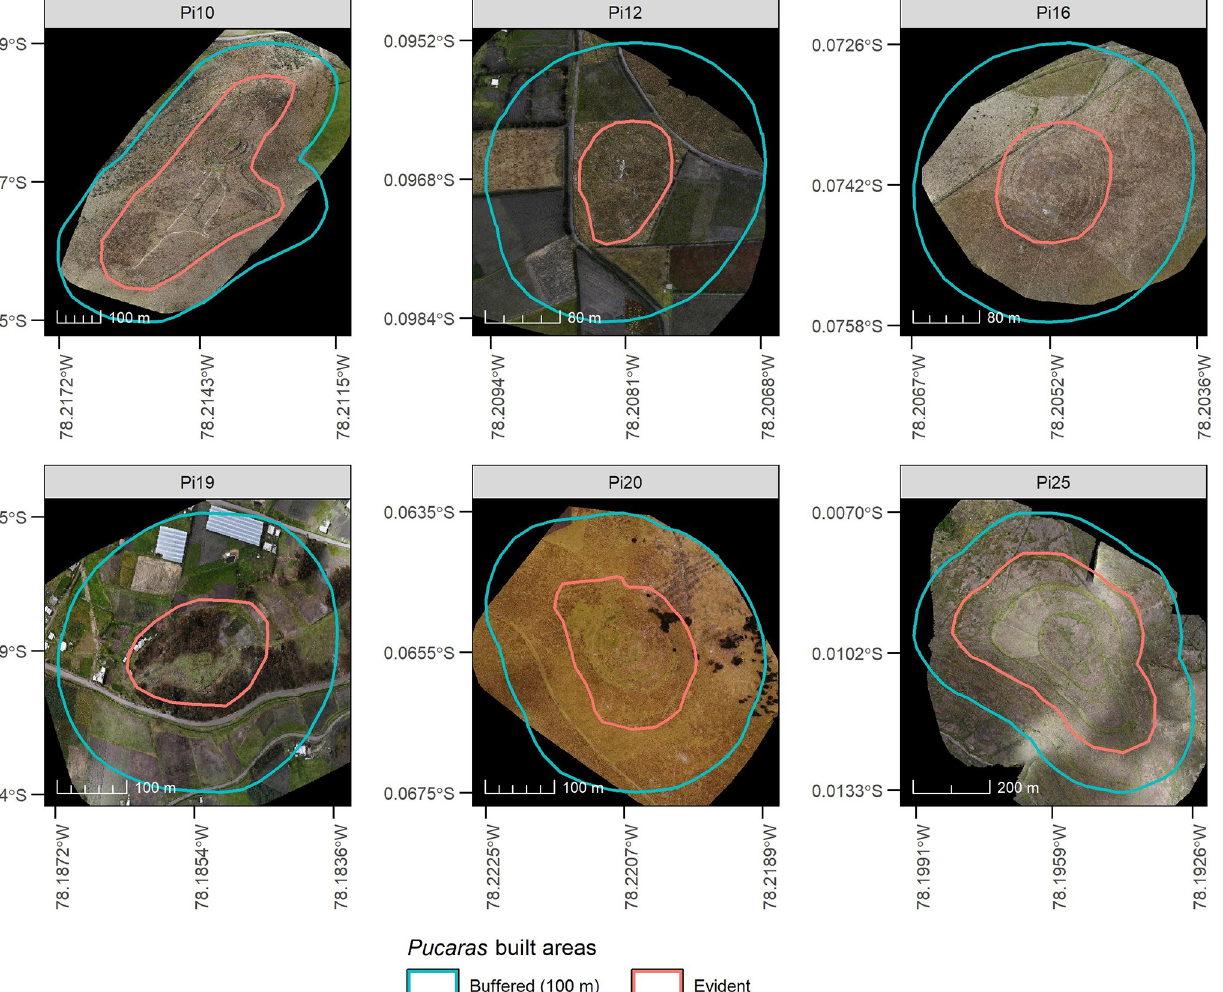
PLOS ONE | https://doi.org/10.1371/journal.pone.0281869 February 23,